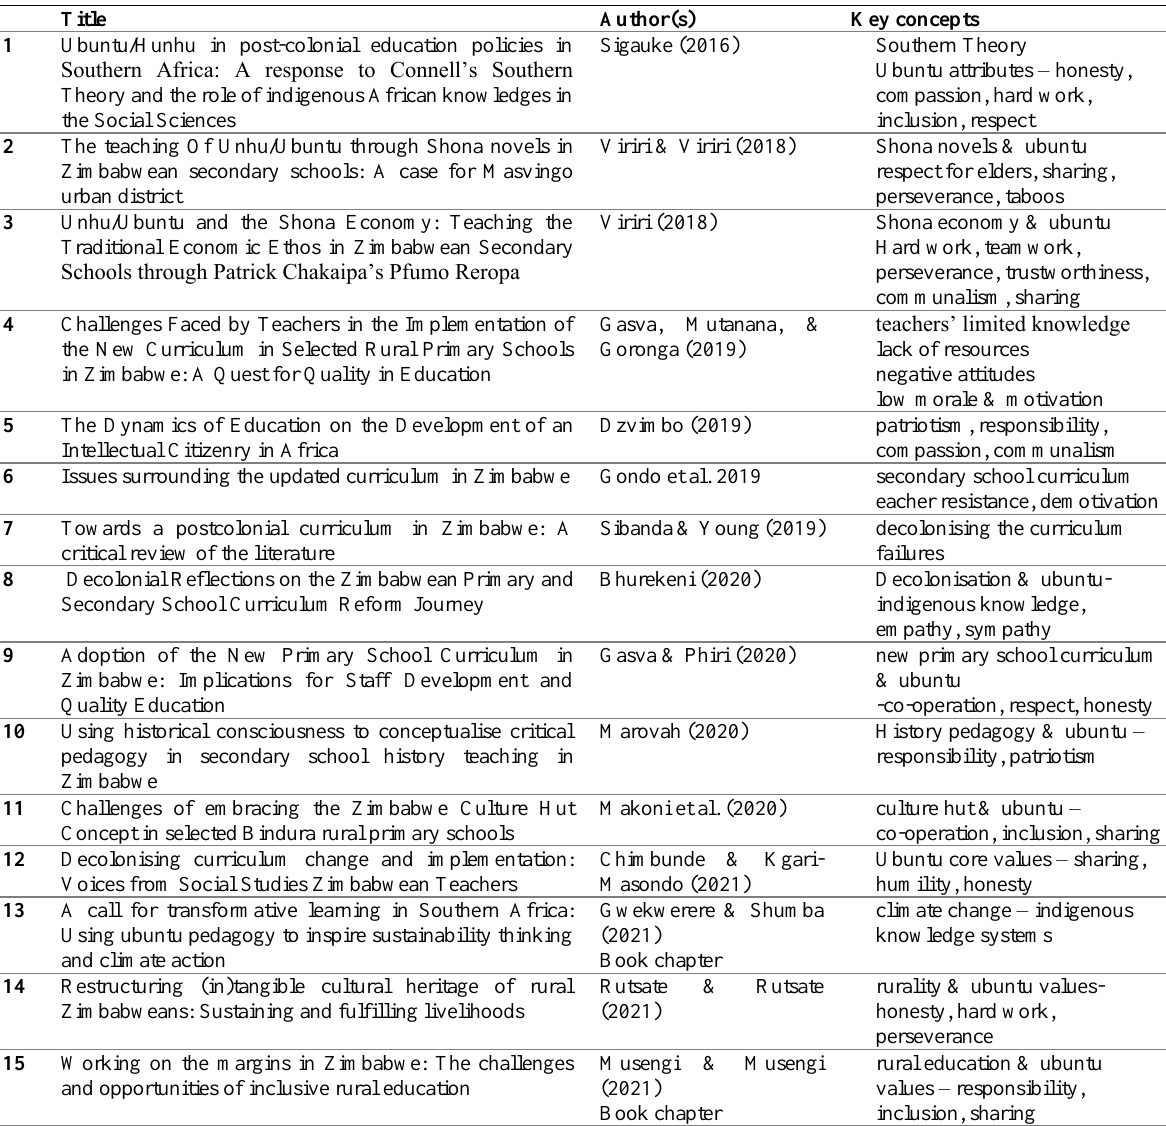
Table 1: Reviewed publications on Ubuntu and the New Curriculum in